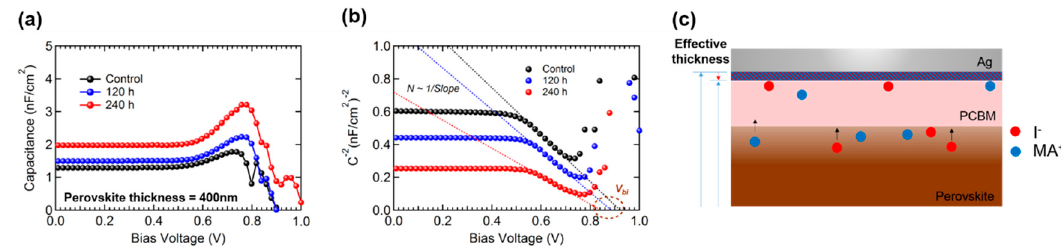
Figure 3. ( a ) C–V plot and ( b ) Mott–Schottky plot for the control, 120 and 240 h air exposed PSCs. ( c ) Schematic for the effective thickness decrease by device degradation.